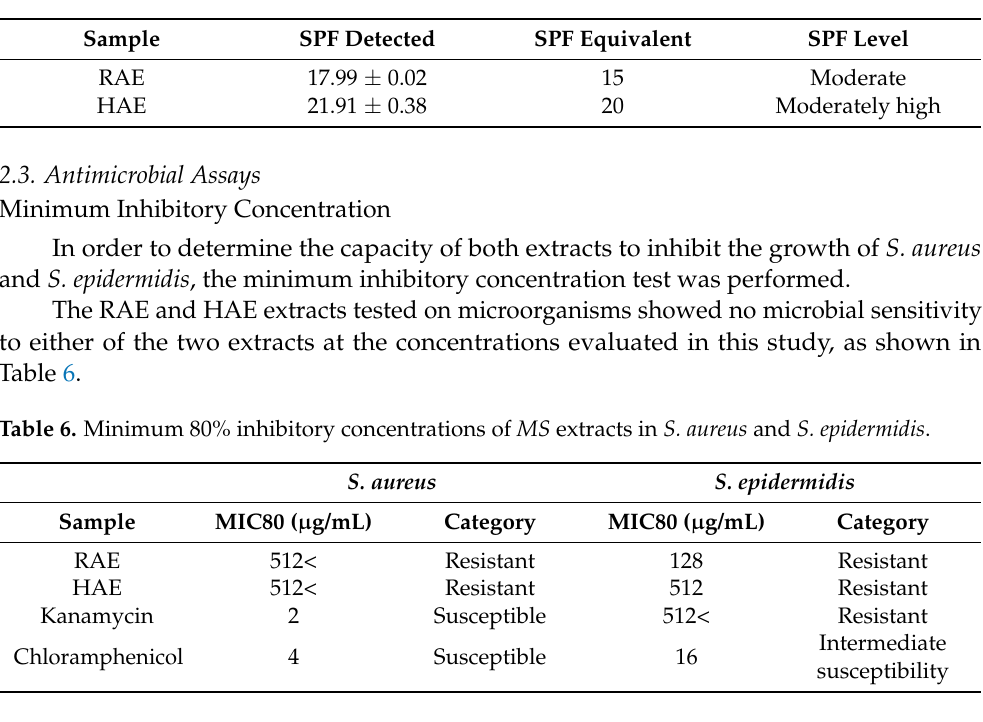
Table 5. SPF measured in MS extracts.